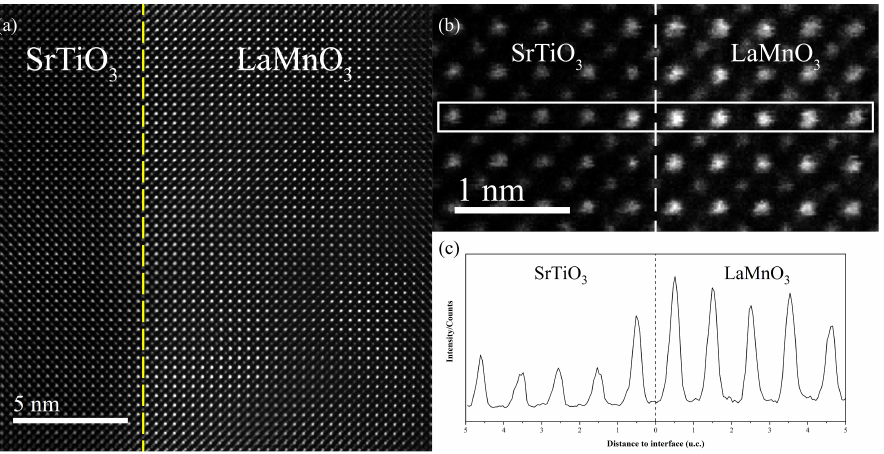
Figure 5. ( a ) ADF-STEM images of the interfaces between LaMnO 3 films and the SrTiO 3 substrate. Yellow dotted lines indicate the positions of the atomically sharp interface; ( b ) ADF − STEM images of the cross-section of LaMnO 3 films with five unit cells of thickness in the [100] direction; ( c ) pixel intensity profile of an ADF line scan.